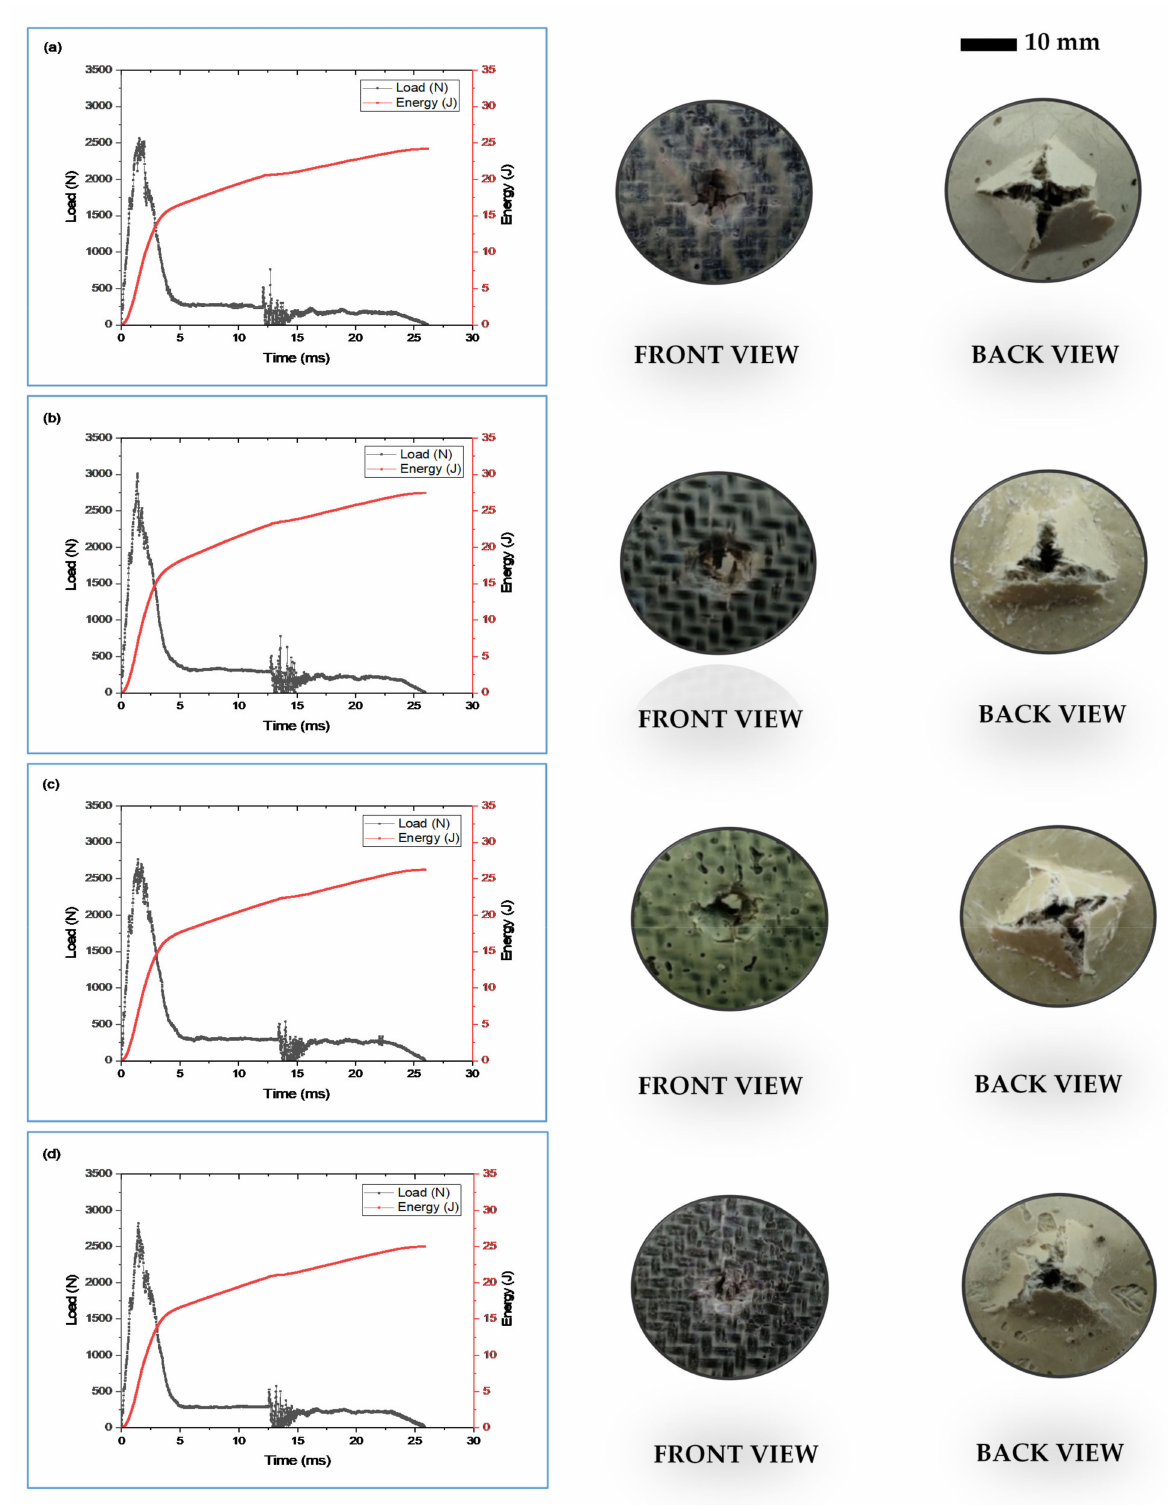
Figure 5. Typical force–time and energy–time curves: ( a ) [WB/GCSM]; ( b ) [WB/GCSM/1GD]; ( c ) [WB/GCSM/3GD]; and ( d ) [WB/GCSM/1GD], with corresponding images of the front and back view after the impact